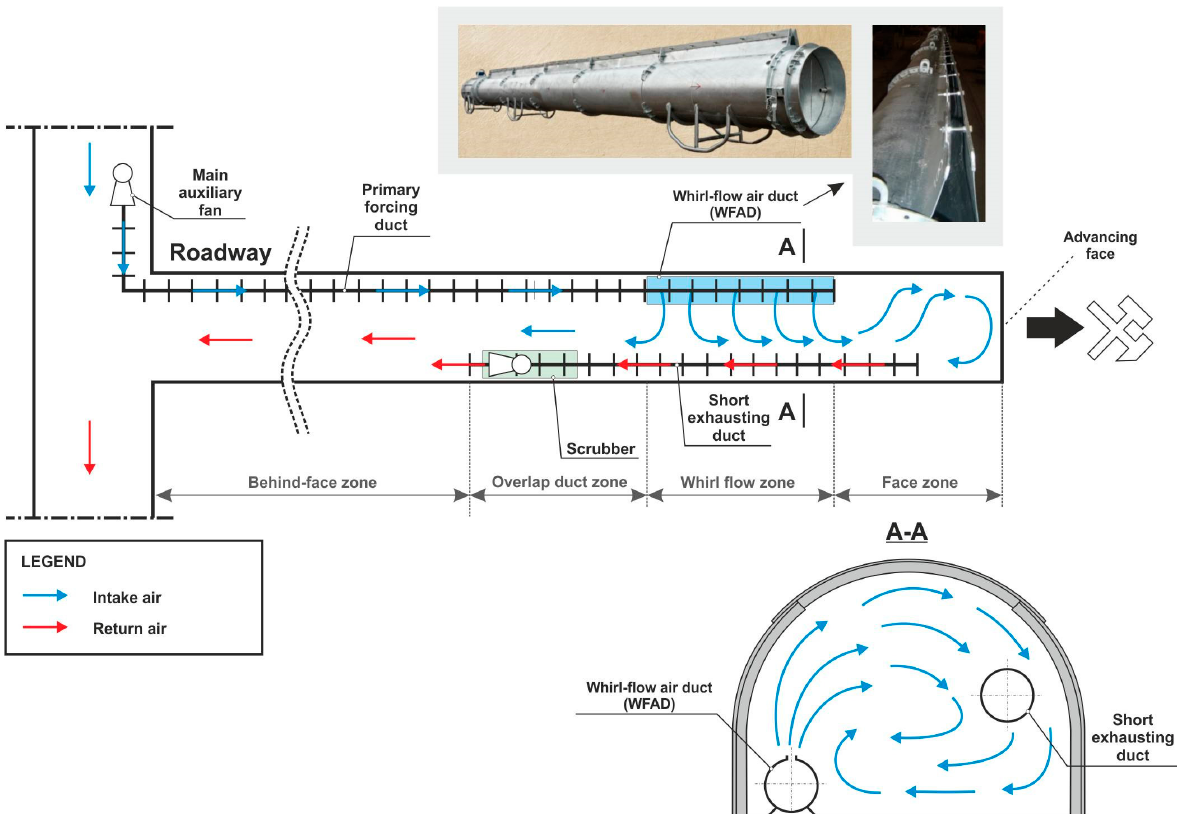
Figure 1. Layout of the primary forcing with exhaust overlap ventilation system.